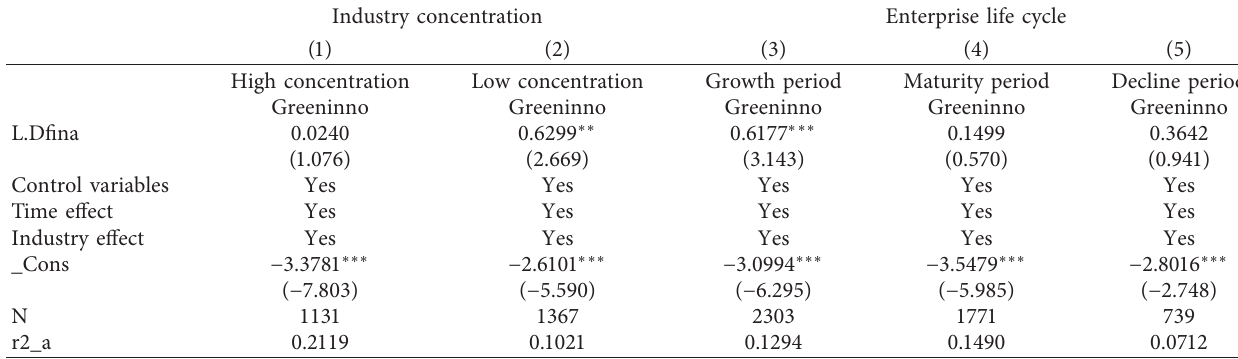
Table 4: Regression results of enterprise characteristics heterogeneity.